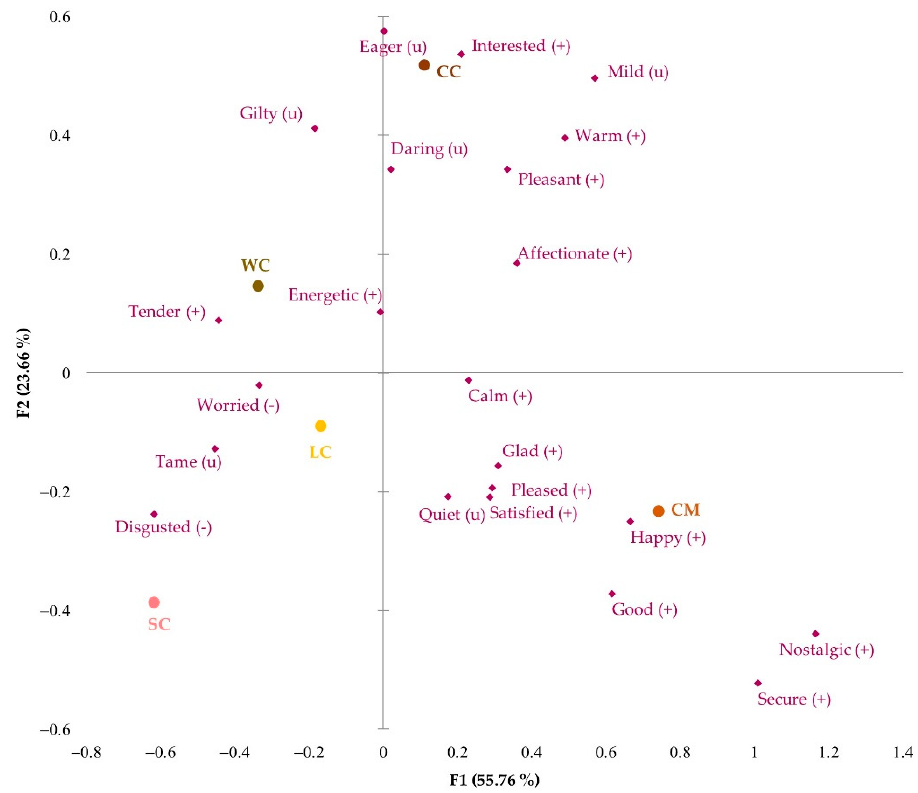
Figure 9. Principal component analysis of the significant emotional responses corresponding to class 3: WC, Walnut cake; LC, Leonor cake; SC, Saffron cake; CC, Coulant cake; CM, Chocomuffin.